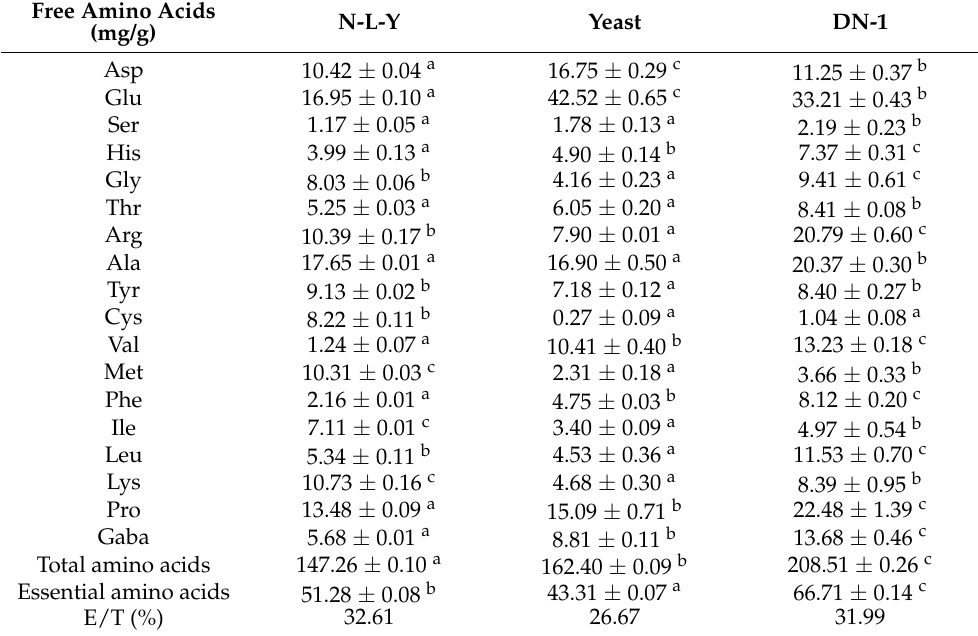
Table 2. Free amino acid content of three kinds of fermented